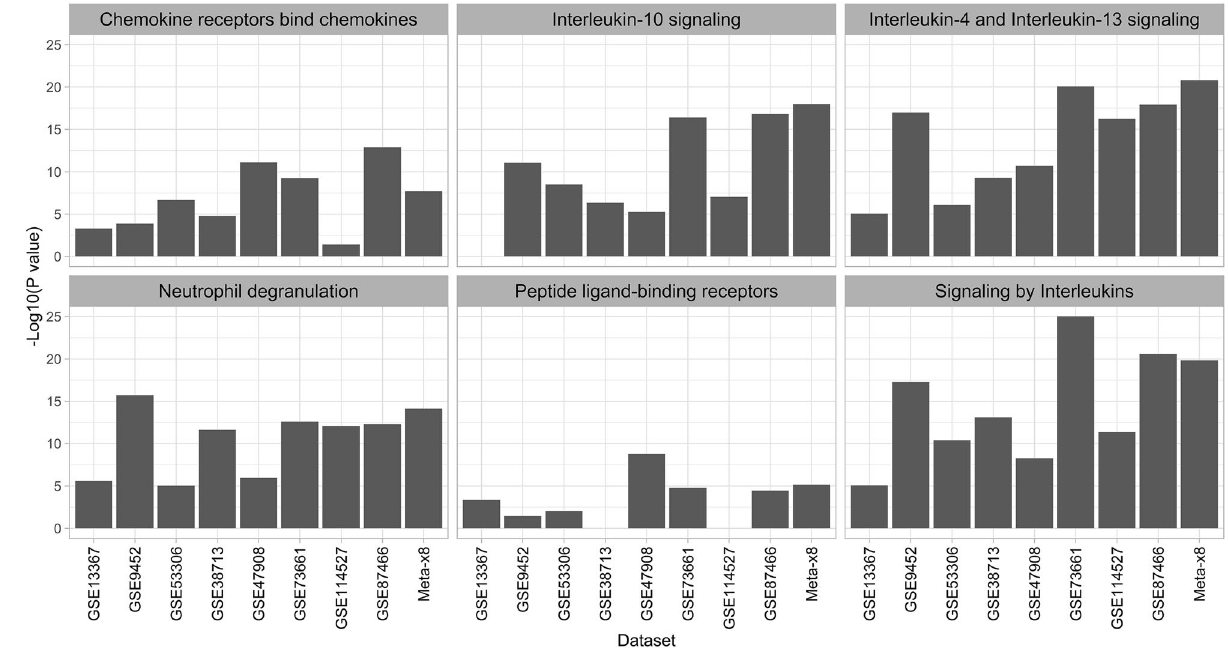
Figure 3. Enrichment of Immune-related Reactome pathways in individual datasets and meta-analysis (Meta- × 8) up-regulated genes. The − log10 of the adjusted P value is shown on the Y-axis with higher bars representing lower adjusted P values.